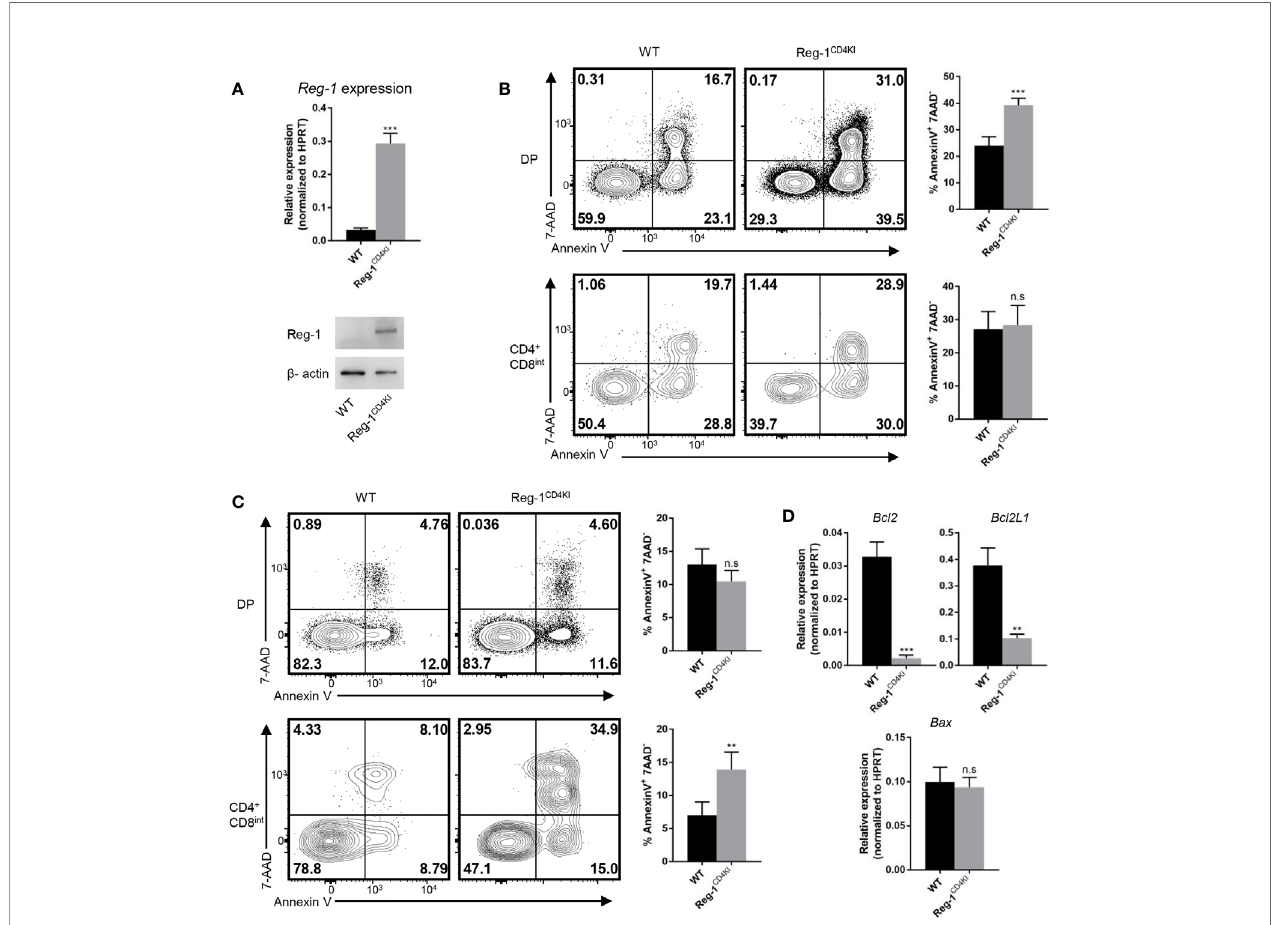
FIGURE 7 | Thymocytes that express mutant Regnase-1 are more susceptible to apoptosis. (A) Immunoblot analysis of Regnase-1 expression and RT-qPCR analysis of Regnase-1 mRNA in sorted DP thymocytes. (B) Flow cytometric analysis of the apoptosis of DP and CD4 + CD8 int thymocytes with anti-CD3 (5 µg/ml) and anti-CD28 (1 µg/ml) for 24h. Bar graph indicates Annexin V + 7-AAD - fraction of DP and CD4 + CD8 int thymocytes. (C) Flow cytometric analysis of the apoptosis of DP and CD4 + CD8 int thymocytes with PMA (50 ng/ml) and ionomycin (500 ng/ml) stimulation for 4h. Bar graph indicates Annexin V + 7-AAD - fraction of DP and CD4 + CD8 int thymocytes. (D) RT-qPCR analysis of apoptotic genes expression. Data are mean ± SD (n=3) from one experiment, representative of three independent experiments. n.s not signi fi cant; ** P < 0.01; *** P < 0.001 (unpaired two-tailed Student ’ s t